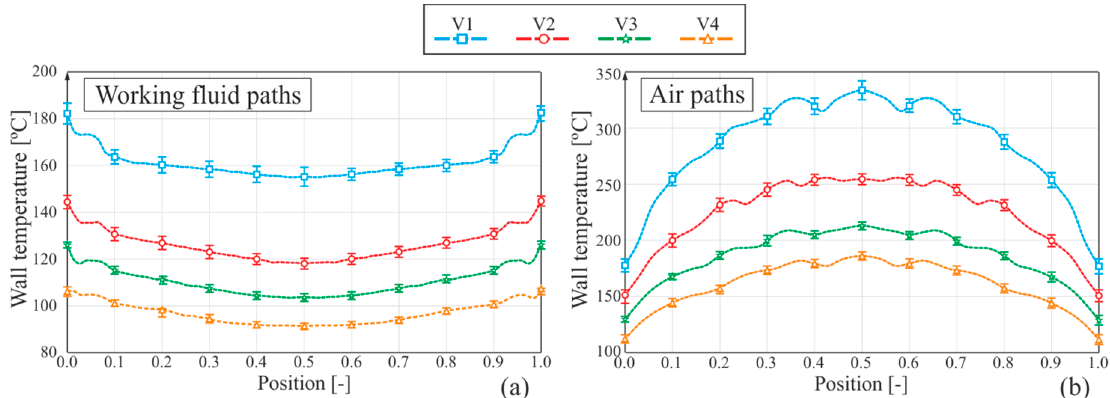
Figure 12. Graphs of vertical temperature profile: ( a ) WF paths and ( b ) in the air.